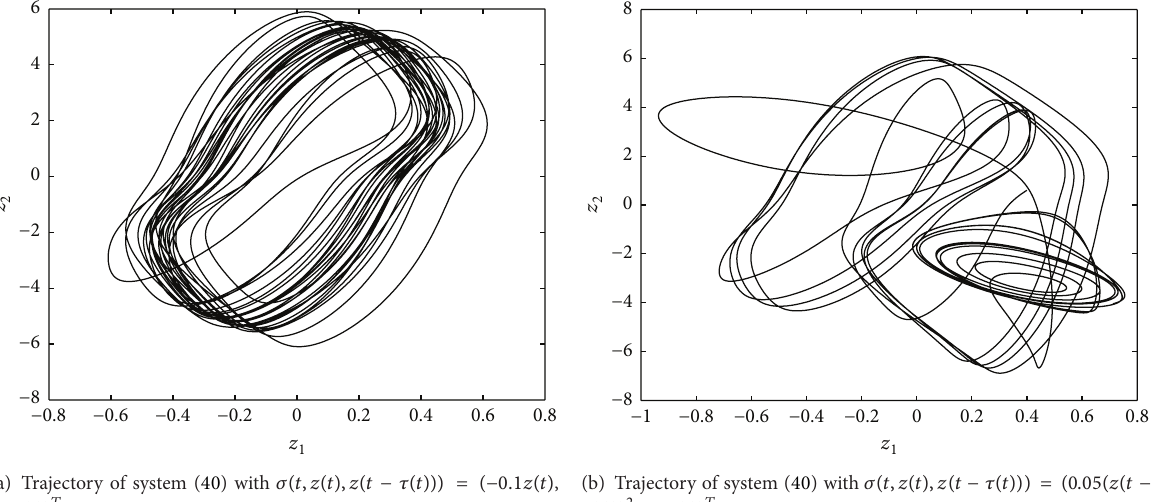
Figure 12: Trajectories of system (40) under different